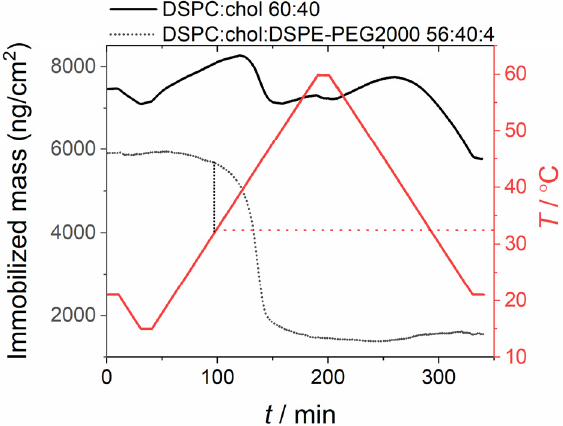
Figure 17. Effect of temperature on the mass (as determined by QCM-D) of immobilized liposome layers formed by DSPC:cholesterol (60:40 moL%—solid line) and by DSPC:cholesterol:DSPE-PEG2000 (56:40:4 moL%—dotted line).